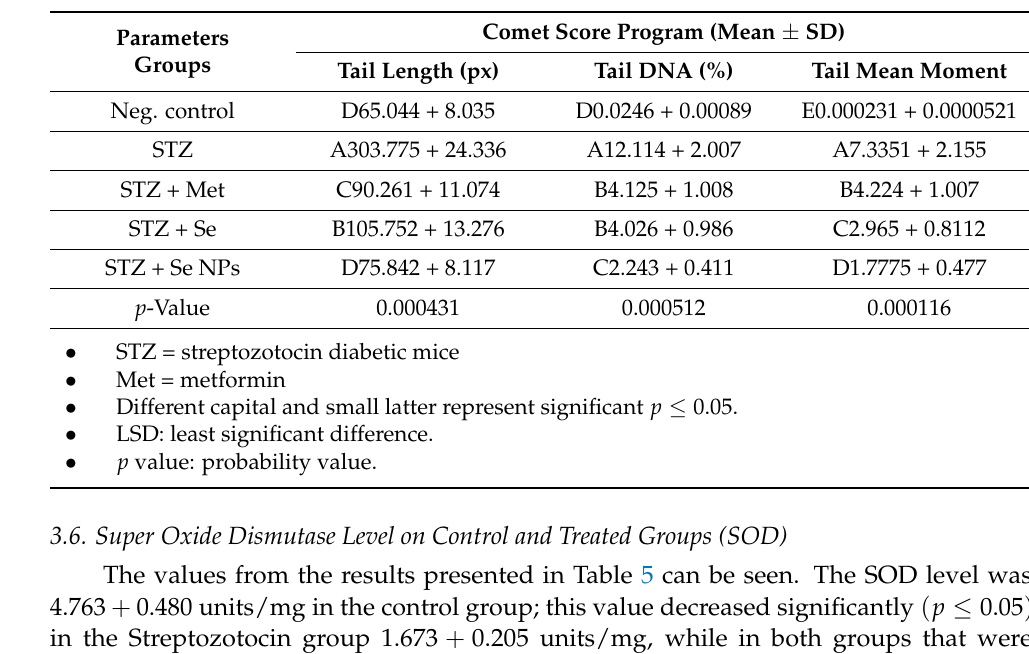
Table 4. Measurement of the tail length, tail DNA percentage and tail moment by using comet score program.